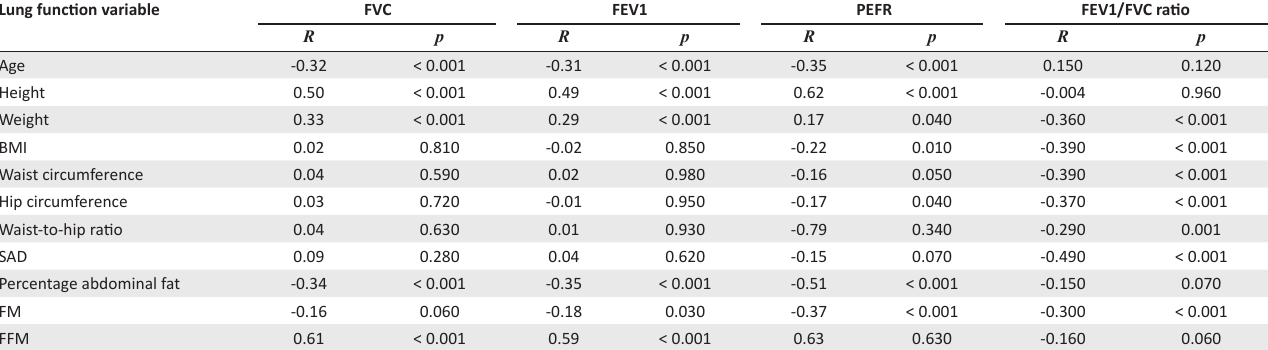
TABLE 3: Correlation between lung function parameters and selected anthropometric variables ( n = 444). Lung function variable